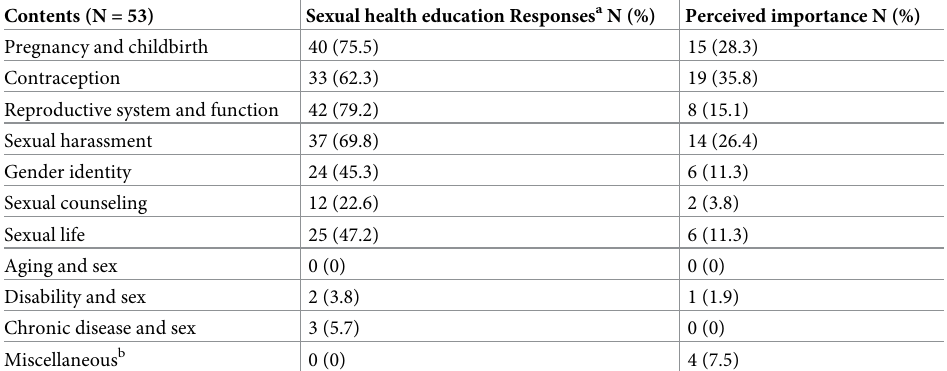
Table 3. Sexual health education contents for participants with congenital heart disease